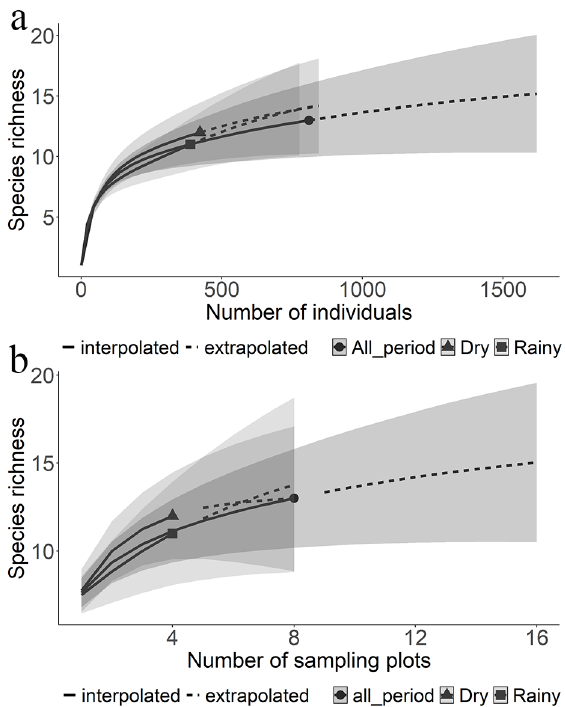
Figure 1. Individual-based (a) and sampled-size based (b) rarefaction (solid line segment) and extrapolation (dotted line segment) sampling curves for lizard data set. Shaded areas represent 95% confidence